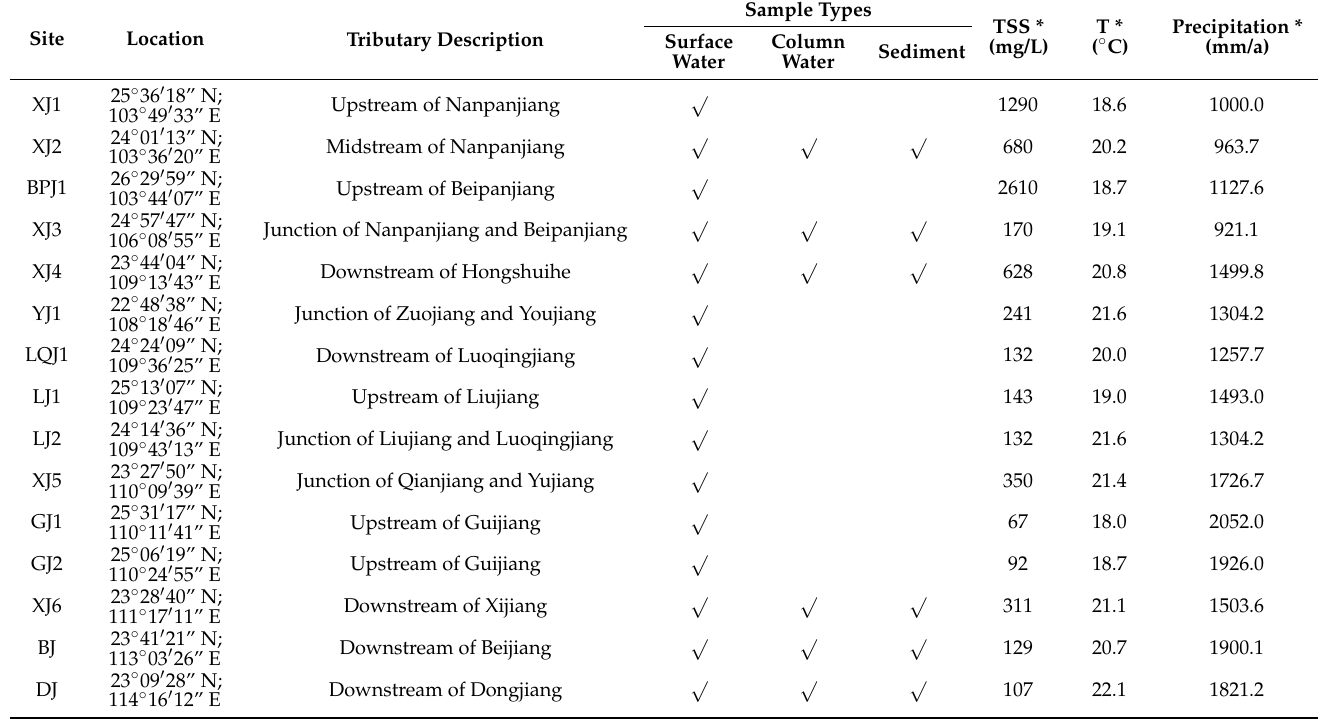
Table 1. Description of sampling